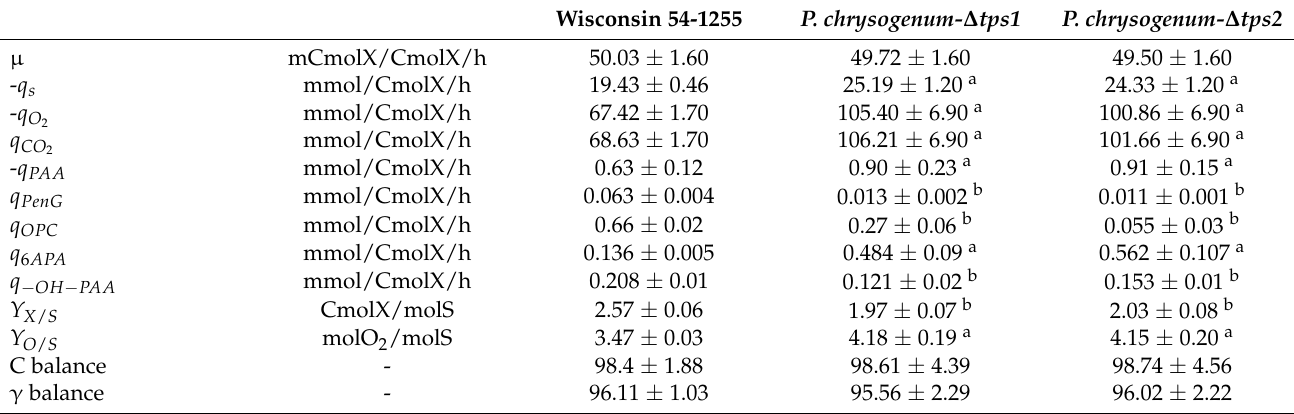
Table 1. Comparison of the reconciled biomass-specific rates and relevant yields of different Penicillium chrysogenum strains on glucose obtained from feast/famine cultures at the average dilution rate of 0.05 h − 1 in the time range of 100–200 h of cultivation. Measurements are given as average ± standard deviation of at least two individual experiments. Significant test was conducted * p < 0.05 vs. WT, by Student’s t -test. Numbers marked with superscript a and b means significantly increased and decreased,